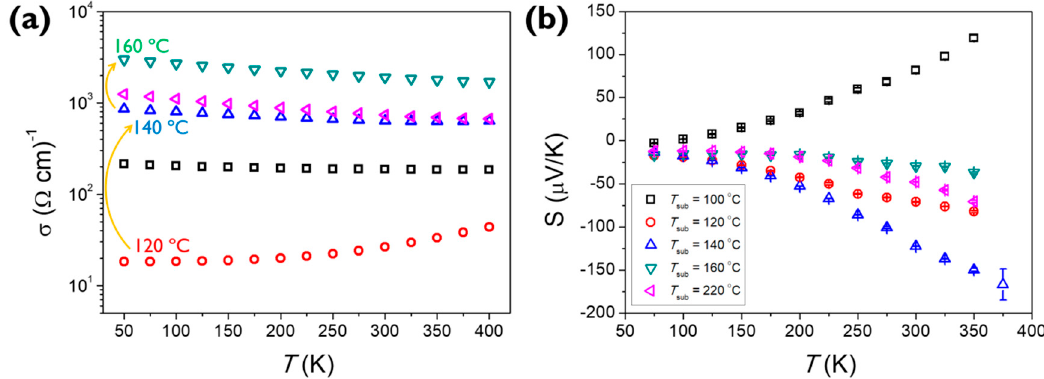
Figure 11. Electrical and thermoelectric characterization of Bi 2 Te 3 thin films grown at different T sub . ( a ) The electrical conductivity, σ . ( b ) The Seebeck coefficient, S. Adapted from reference [13].